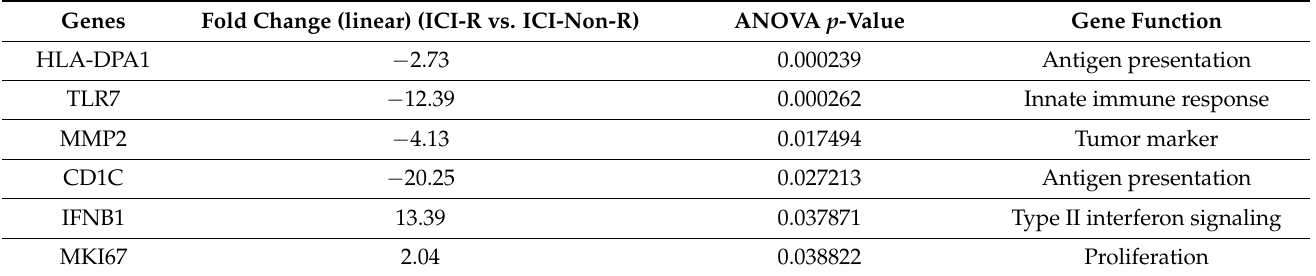
Table 4. Differentially expressed genes between ICI-Responders and ICI-Non-Responders. Genes Fold Change (linear) (ICI-R vs. ICI-Non-R) ANOVA p